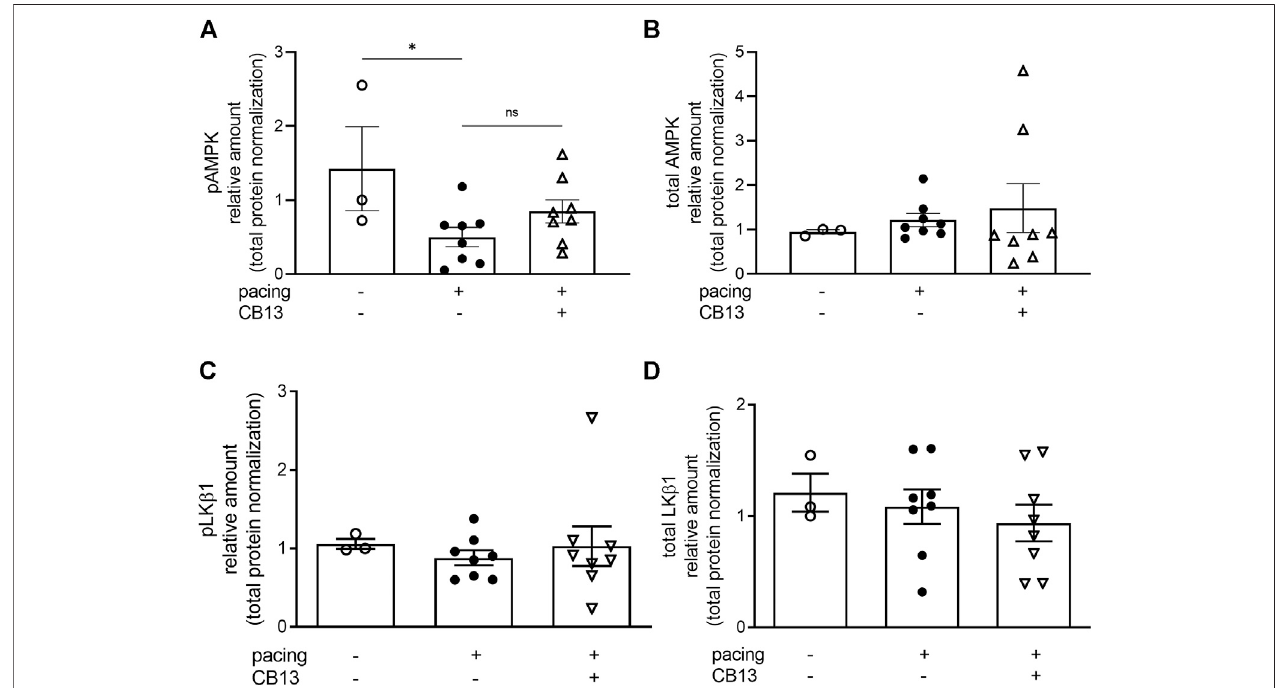
FIGURE 6 | Total AMPK and total LKB1 were not altered in atrial tissue. (A) Tachypacing for 1.5 h signi fi cantly reduced pAMPK compared to non-paced atrial tissue (B) but did not alter total AMPK. (C) Phospho-LKB1 and (D) total LKB1 protein expression did notchangebetweengroups. See Figures 5A , B for representative blots. * p ≤ 0.05. ns; not signi fi cant. n (cid:1) 3 – 8. Data presented as mean ± SEM. Data was tested for normality using Shapiro-Wilk normality test. Accordingly, statistical signi fi cance was determined by one-way ANOVA with Holm-Sidak post-hoc for multiple comparisons (A) .